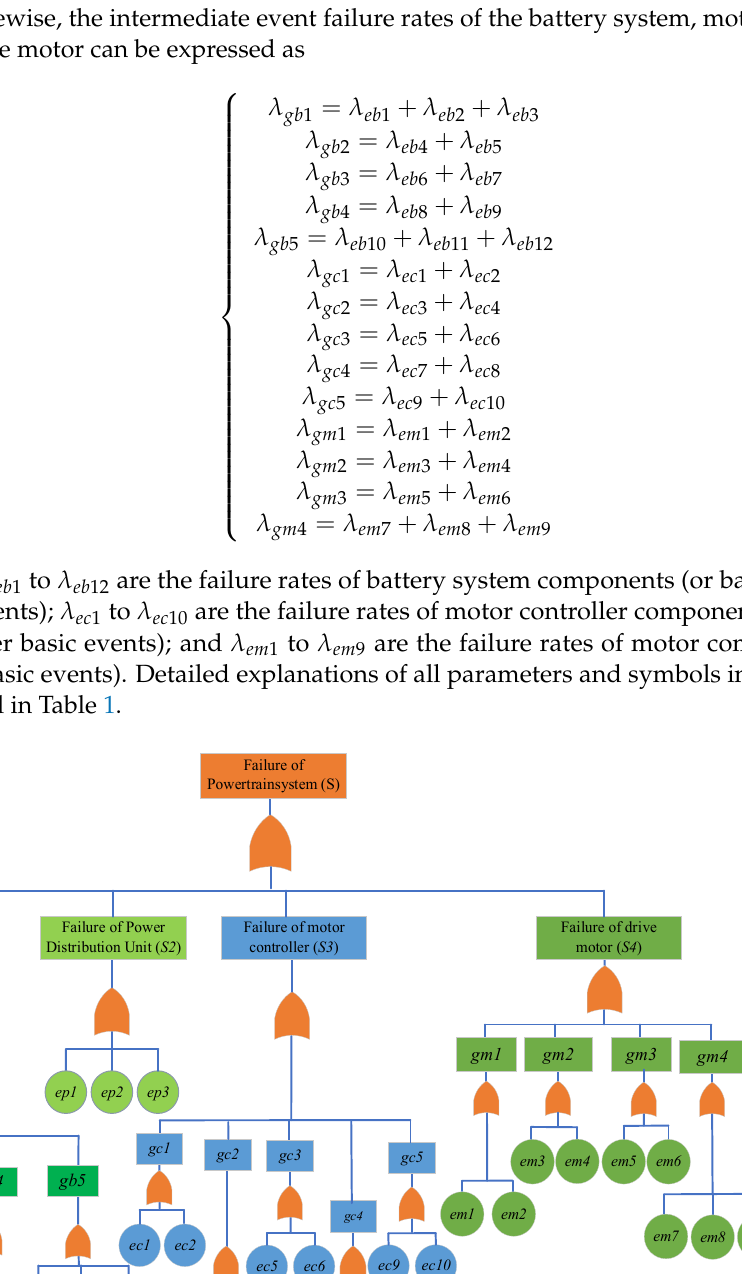
Table 1. Failure events of powertrain system.